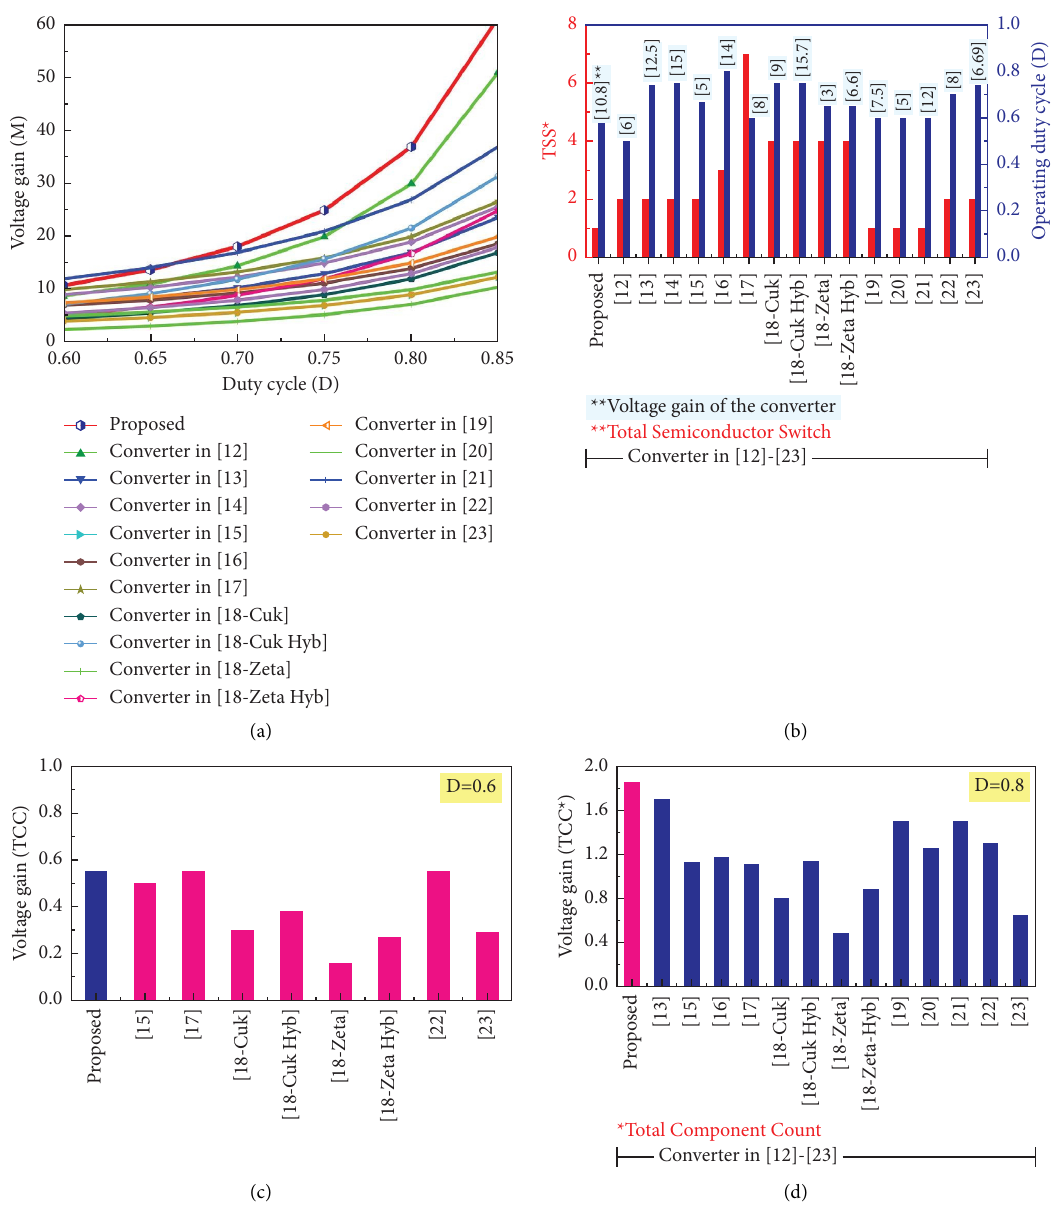
Figure 8: Comparison of the proposed converter with recently developed converters found in [12–23]. (a) Voltage gain vs duty cycle. (b) TSS vs duty cycle. (c) Voltage gain/TCC for D � 0.6. (d) Voltage gain/TCC for D �